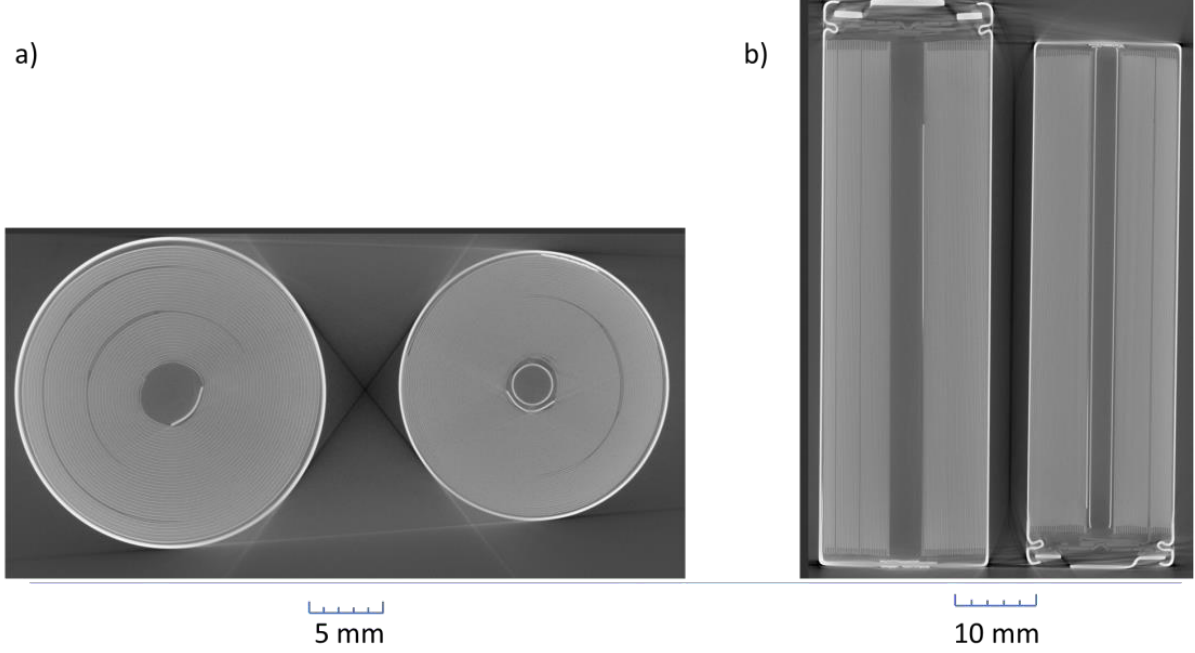
Figure 2. Comparison of X-ray photos of: ( a ) top-view of the in this study investigated 21700 ( left ) and 18650 ( right ) Li-ion cell. ( b ) front-view of 21700 Li-ion cell ( left ) and 18650 Li-ion cell ( right ).